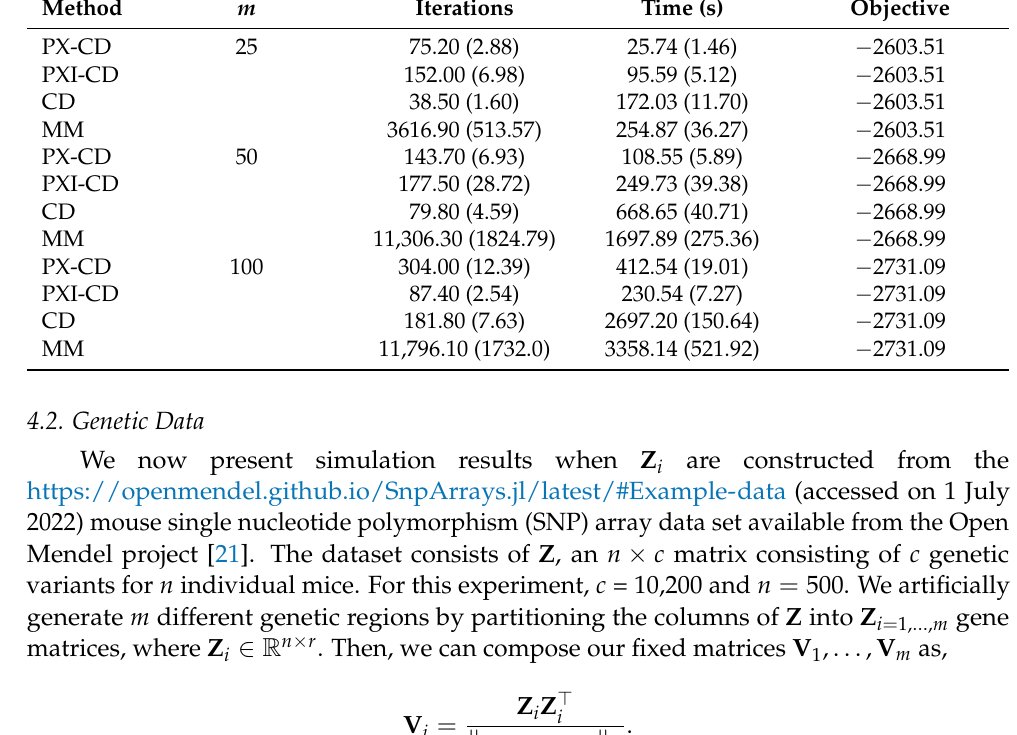
Table 6. The convergence results when V i are full-rank, n = 1000, and γ 0 = 10.